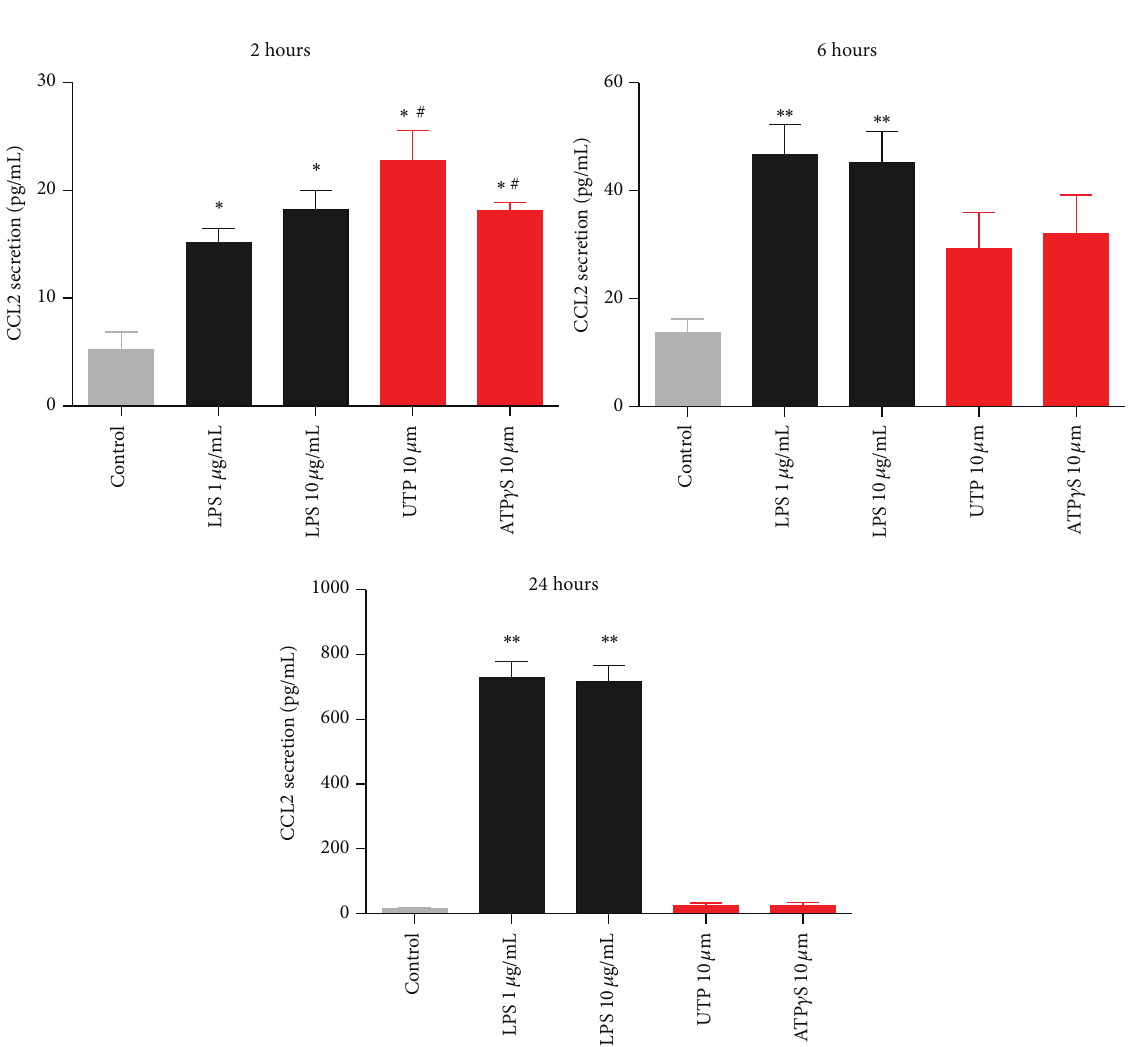
THP-1 monocytes and found several synonymous SNPs and a single nonsynonymous SNP (rs3741156) altering amino acid 312 from arginine (R) to serine (S) (data not